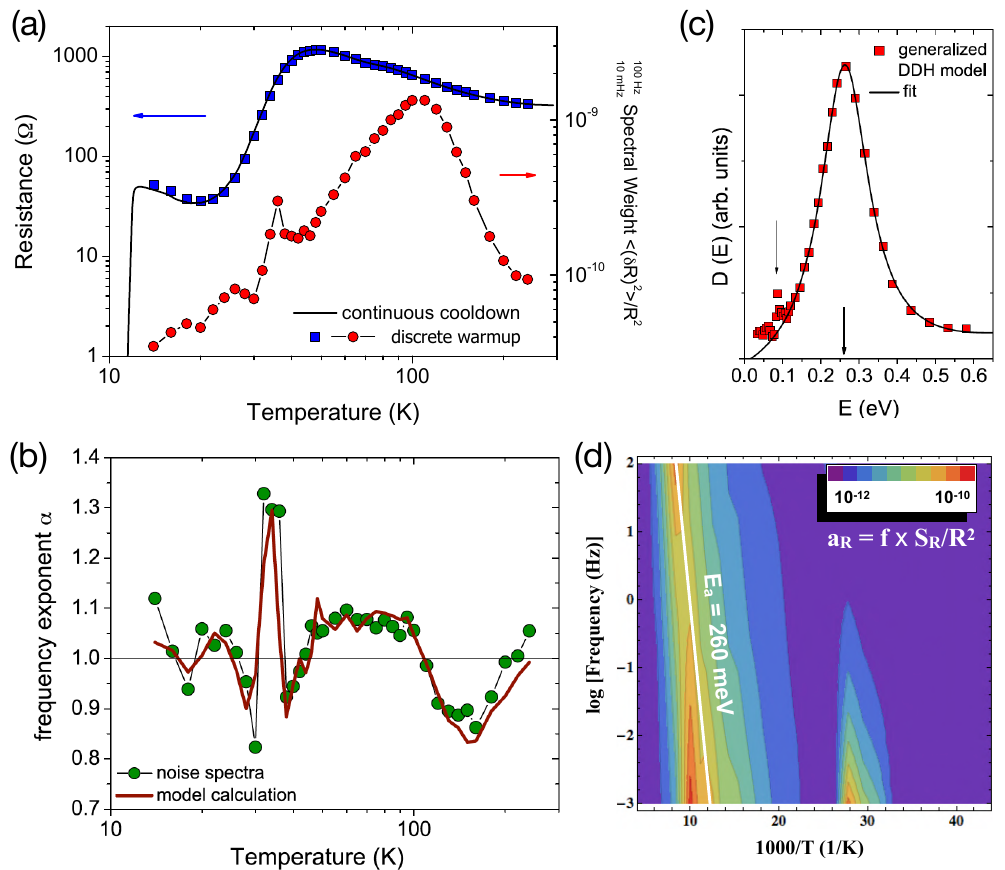
Figure 7. Noise spectroscopy and DDH analysis (see text) on fully-deuterated κ -(D 8 -ET) 2 Cu[N(CN) 2 ]Br. ( a ) resistance (blue squares) and integrated noise PSD (red circles) of a fully-deuterated sample κ -(D 8 -ET) 2 Cu[N(CN) 2 ]Br; ( b ) corresponding frequency exponent α ( T ) (green circles) and model calculation within the generalized DDH model (Equation(16)) (red line); ( c ) distribution of activation energies D ( E ) at f = 1Hz calculated using Equation(18). Arrows indicate the two strongest maxima at 260meV and 90meV; ( d ) contour plot of the relative noise level a R = f S R / R 2 vs. frequency f and × temperature T in an Arrhenius representation. The slope of the white line corresponds to an activation energy of E a = 260meV, corresponding to the maximum in D ( E ) in ( c ) as extracted from the DDH model. Reproduced from [92,93]. Copyright IOP